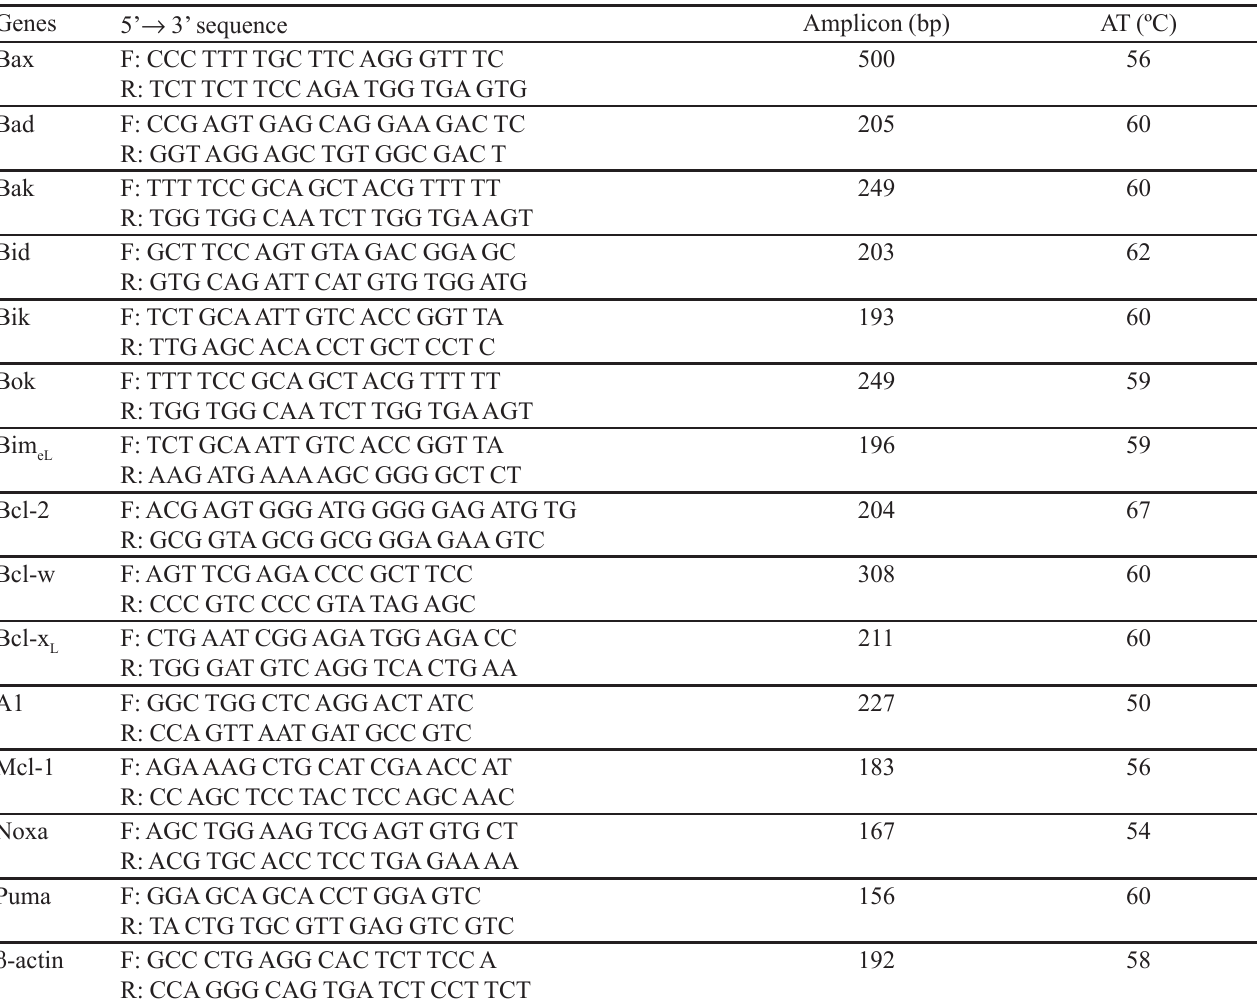
TABLE II - Primers sequences, amplicon size and their specific annealing temperature for quantitative real-time PCR Genes 5’ → 3’ sequence